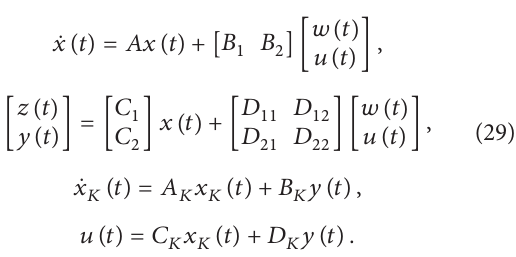
Figure 8: Two-port diagram.